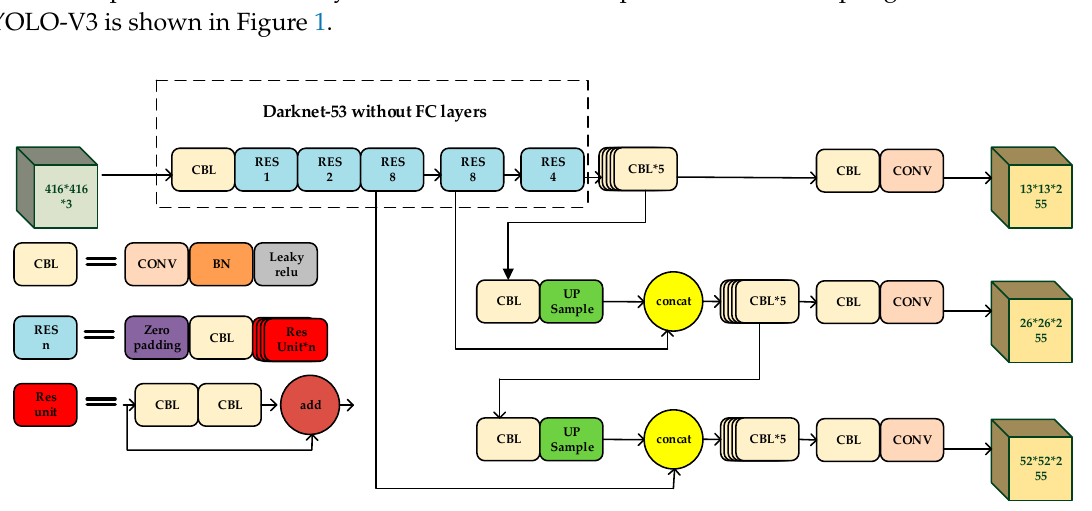
Figure 1. The structure of You Only Look Once (YOLO)-V3 network.